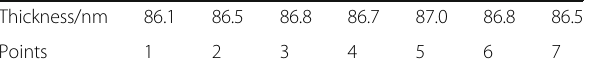
Table 2 The extracted thickness of the 2-inch size AlN film at